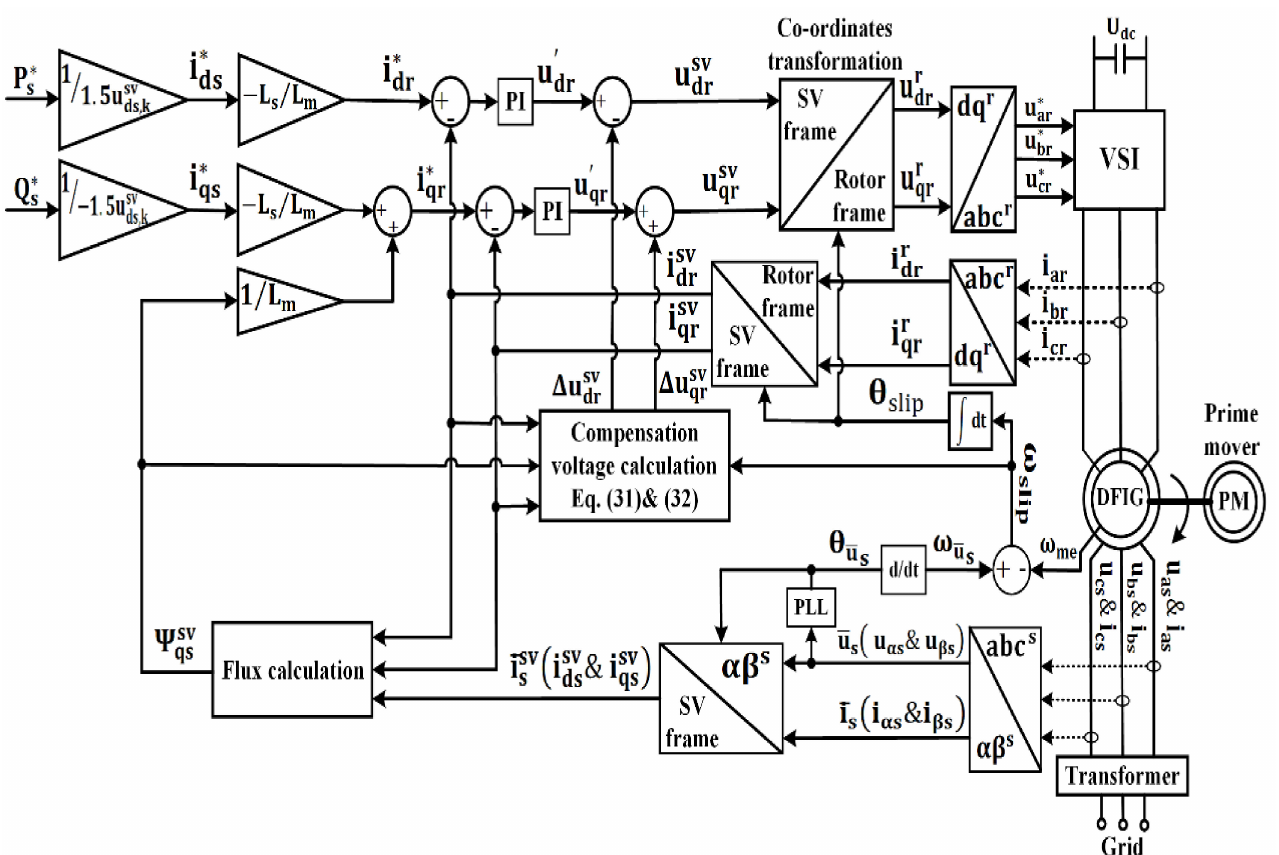
Figure 5. SVOC technique for the